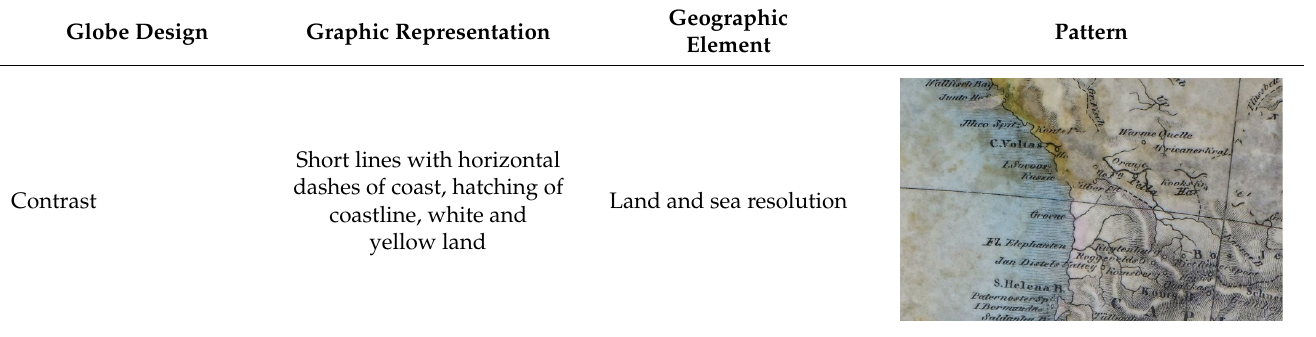
Table 1. Parameters for image acquisition and 3D visualization of black-and-white graphics. Source: Map Collection of the Faculty of Science, Charles University.